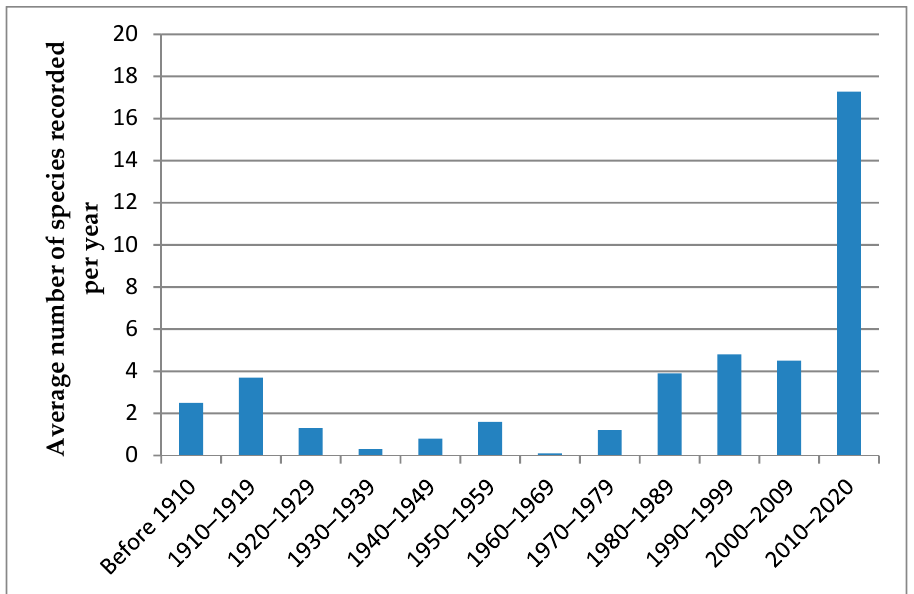
Figure 2. Intensity of ladybird collection in the region in different periods.